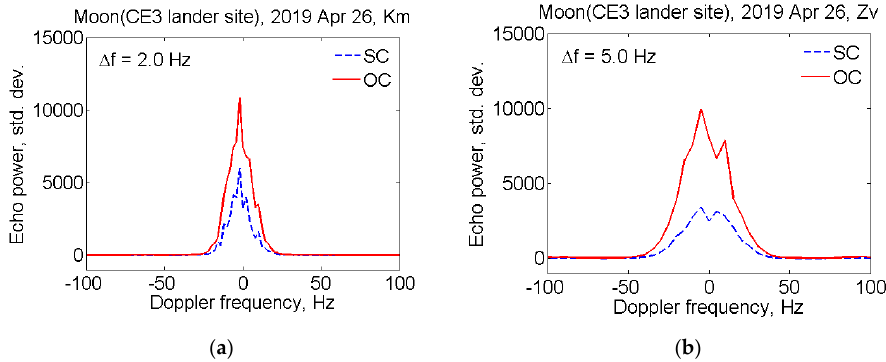
Figure 1. Opposite (OC) (red solid line) and same circular polarizations (SC) (blue dashed line) echo